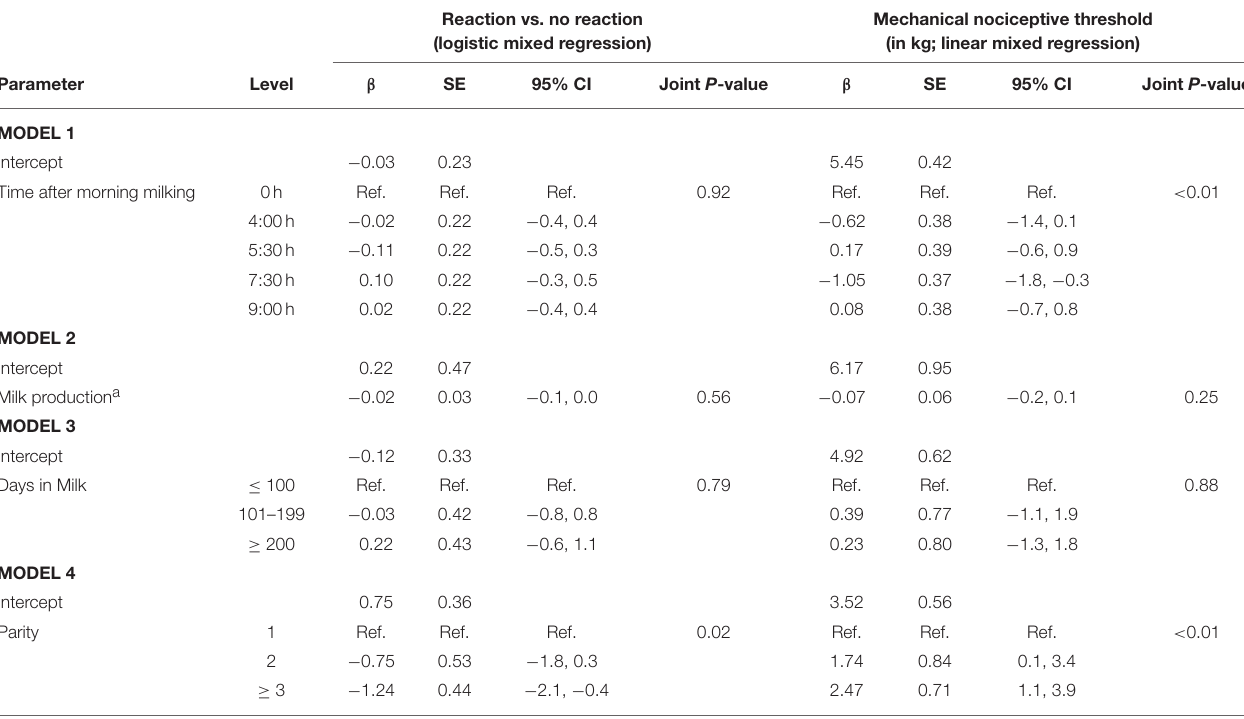
TABLE 1 | Unconditional associations between predictors and odds of reacting to an algometer (reaction vs. no reaction) and between predictors and mechanical nociceptive threshold (in kg; for cows reacting to pressure exerted with an algometer). Reaction vs. no reaction (logistic mixed